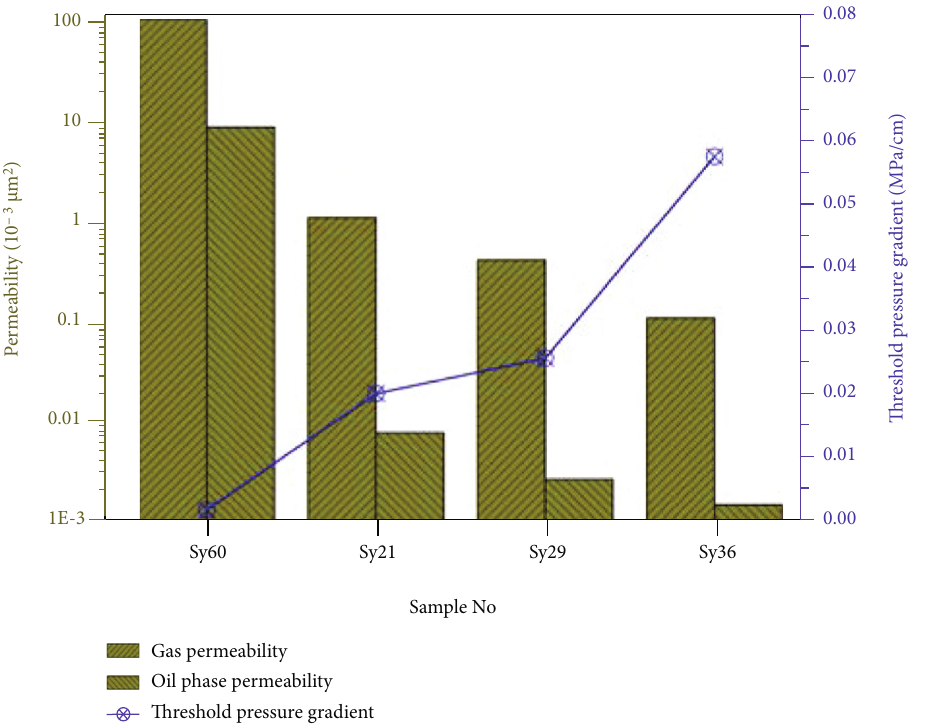
Figure 14: The relationship between the threshold pressure gradients and the air permeabilities of the core